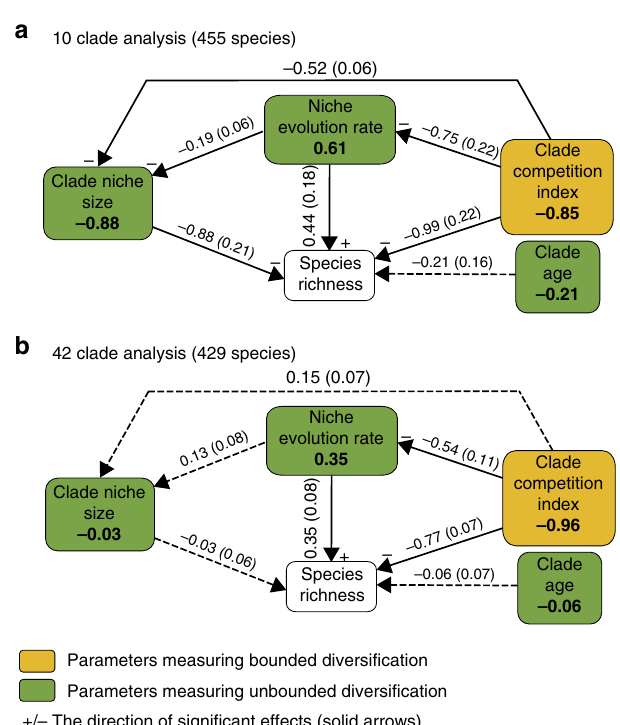
Fig. 3 Path analysis of variation in conifer species richness. Bayesian path analysis showing the relative effects of niche and phylogenetic parameters on clade species richness for 455 conifer species in a 10 large clades and b 42 smaller clades. Total effect size is shown in bold, while direct effects and their standard deviation are shown along the vertices. Solid lines indicate signi fi cant effects (95% credible intervals not including